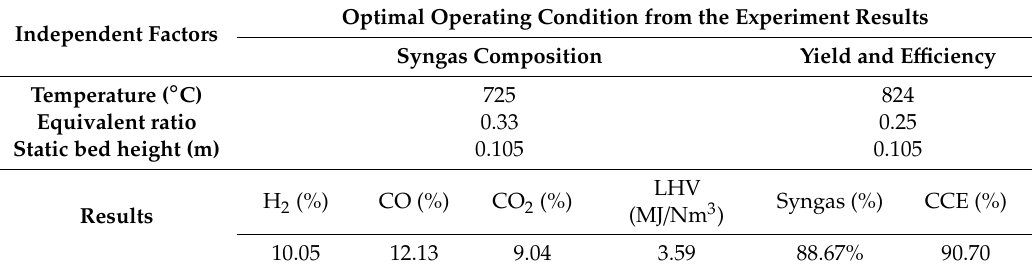
Table 4. Most e ff ective values of independent variables for experiment